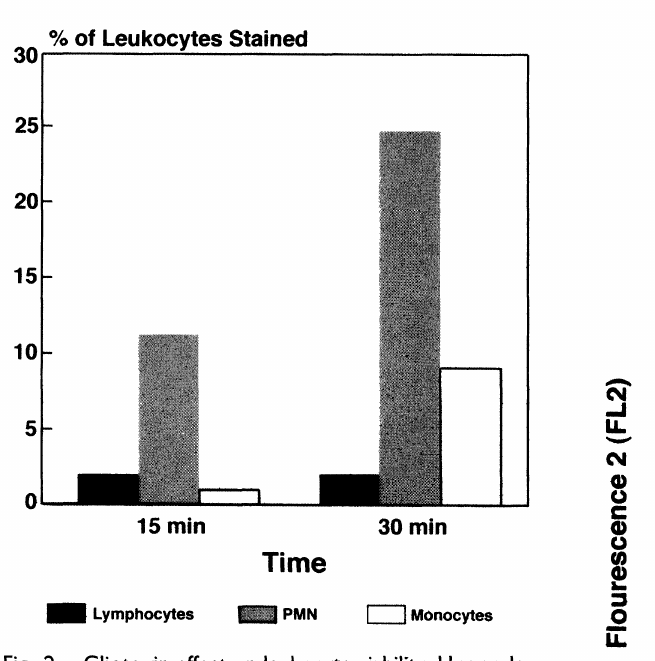
Fig. 2. Gliotoxin effect on leukocyte viability. Human leu- kocytes were exposed to 500 IJg/mL of gliotoxin for 15 and 30 minutes. Viability was measured by propidium iodide uptake. PMN were the most affected when compared with lymphocytes and monocyte populations of the peripheral blood.